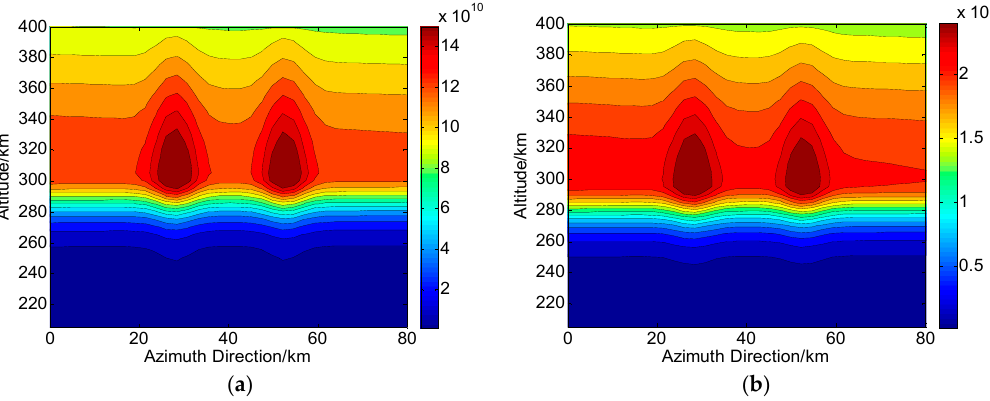
Figure 4. The true distributions of electron density in areas of ( a ) Changbai and ( b ) Qingdao. The unit of the electron density is electrons · m − 3 . Remote Sens. 2017 , 9 , 1169